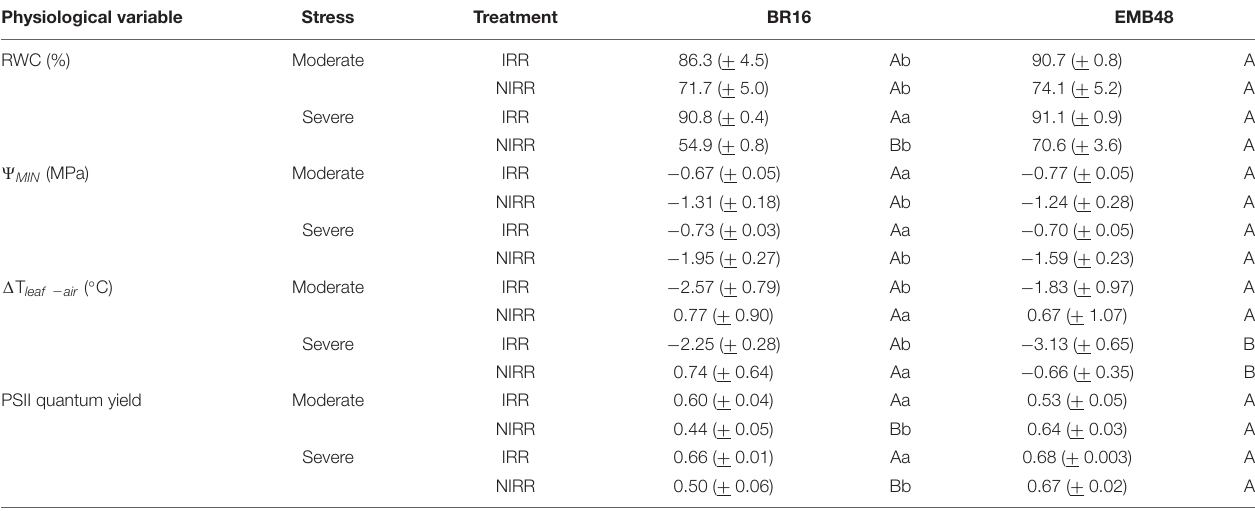
TABLE 4 | Physiological variables of two soybean cultivars (BR16 and EMB48) at the R1 developmental stage under moderate and severe water stress. Physiological variable Stress